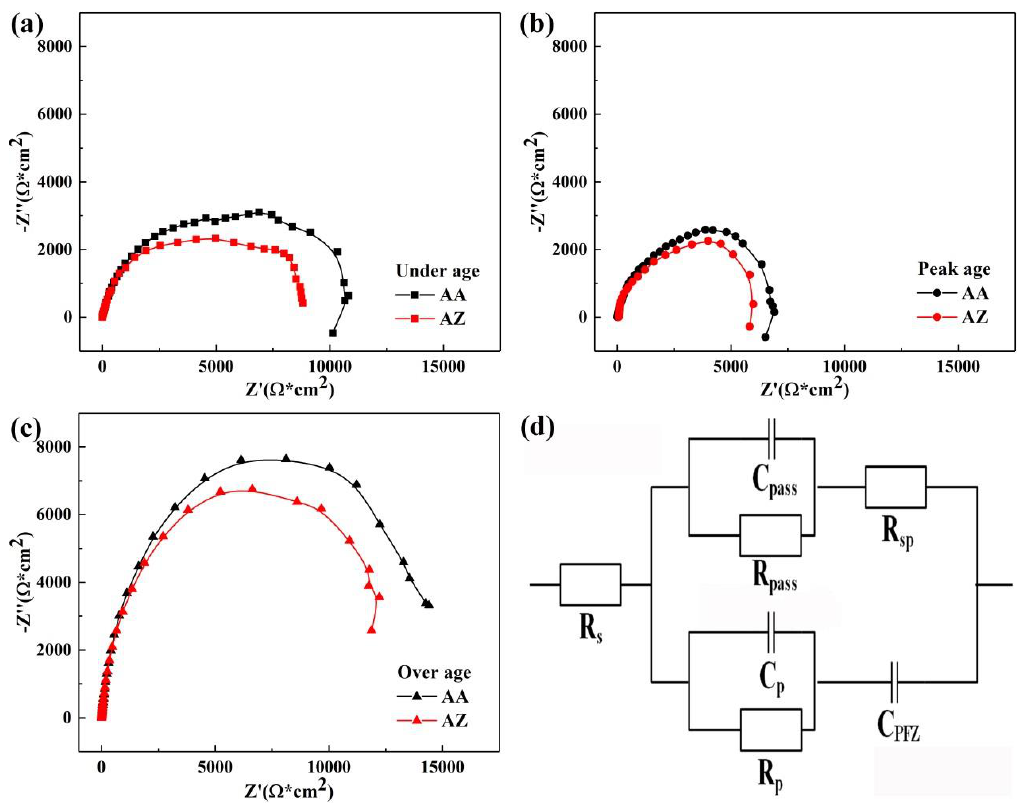
Figure 11. Nyquist plots of alloy AA and AZ under different aged conditions at 170 °C: ( a ) under aged, ( b ) peak aged, ( c ) over aged, and ( d ) equivalent circuit. Table 7. Parameters of EIS test